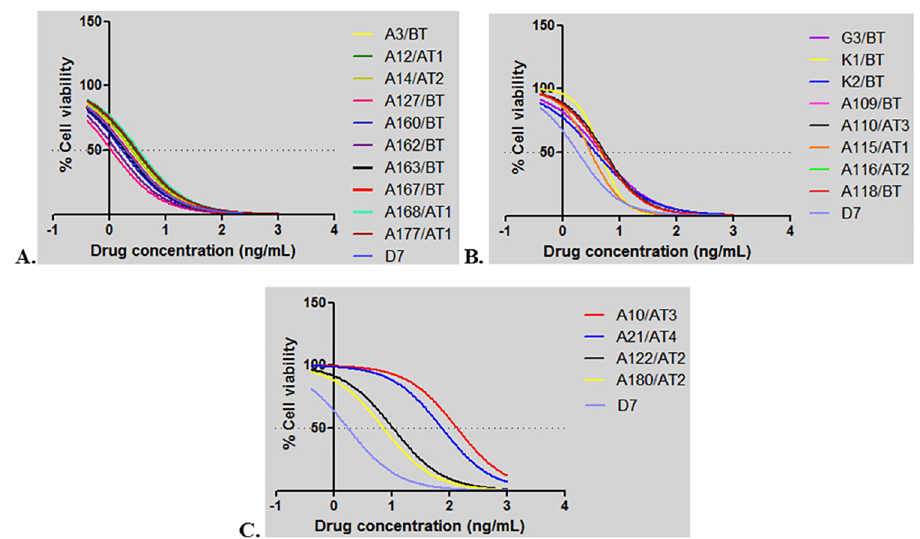
Fig 1. MTT assay of T . annulata infected cell lines. A. T . annulata isolates with low IC 50 values (2–3 ng/mL). B. T . annulata isolates with medium IC 50 values (3–7 ng/mL). C. T . annulata isolates with IC 50 values over (7 ng/mL). Numbers on the x axis (-1, 0, 1, 2, 3 and 4) indicates drug concentrations used to treat cell lines at doses of 0, 0.8, 7, 125, 1000 and 1500 ng/mL, respectively.